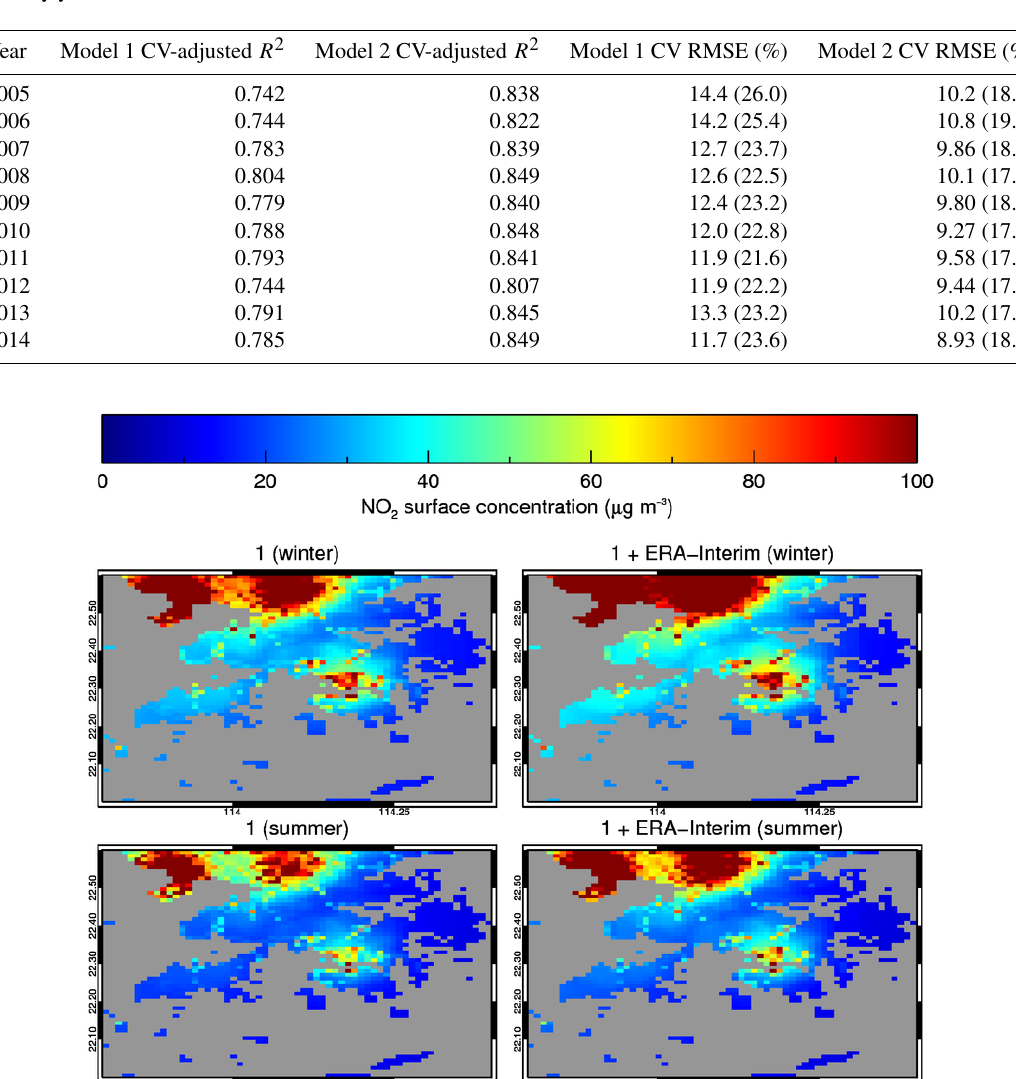
Figure 6. The mean surface NO 2 concentration predicted by Model 1 and 2 during winter (November–April) and summer (May–October) between 2005 and 2015, with and without the inclusion of wind speed and temperature from the ERA-Interim reanalysis dataset (Dee et al.,